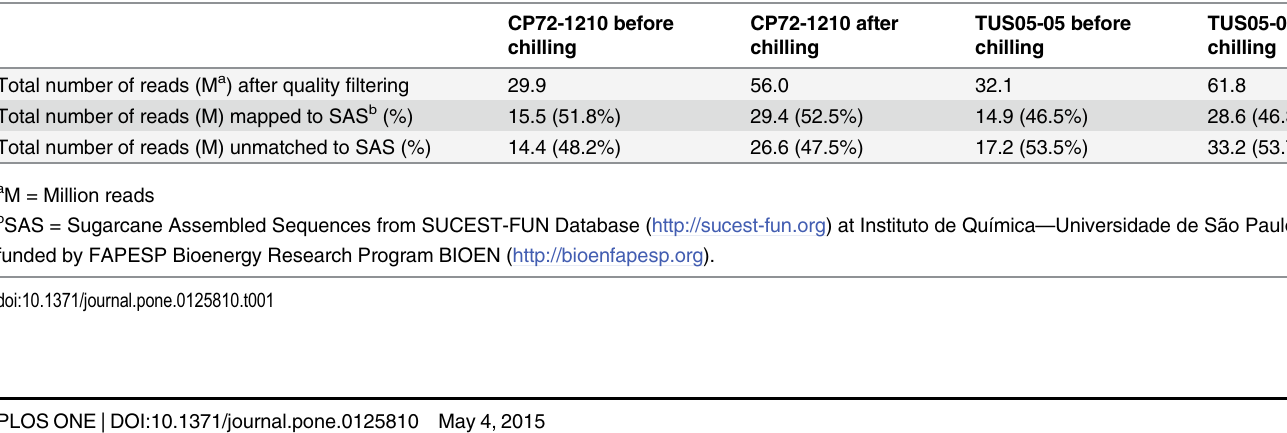
Table 1. Summary of RNA-Seq data of sugarcane CP72-1210 and S . spontaneum